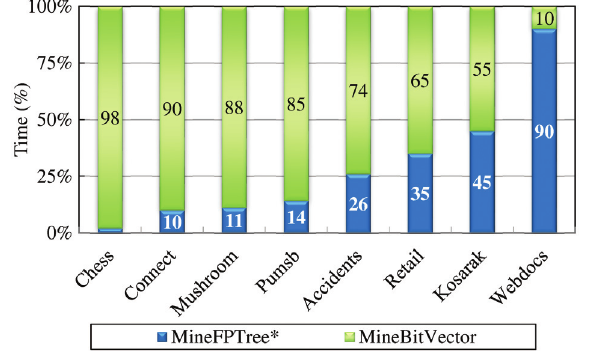
Figure 14. Time Distribution of Two Mining Strategies in DFEM.